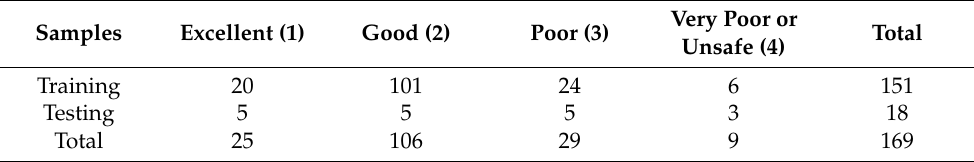
Table 2. Distribution of the training and testing samples according to the WQI